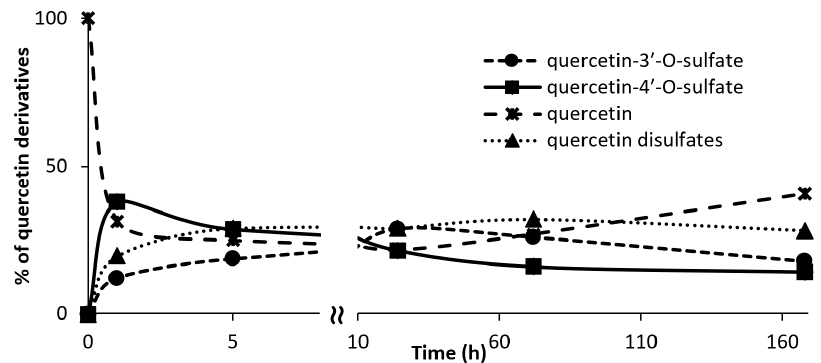
Figure 1. Quercetin sulfation vs. time. The percentage of soluble quercetin derivatives was calculated from the peak areas of the respective compounds. In the case of quercetin disulfates, the total percentage of all isomers was taken into the calculation.